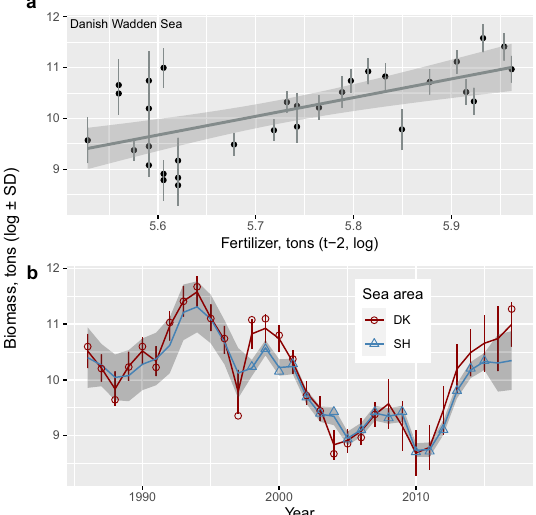
Figure 6. ( a ) Effect of fertilizer application to the Danish (DK) farmland on mussel biomass on the DK Wadden Sea two years later. ( b ) Estimated (lines) and observed (symbols) biomass trends of blue mussel populations in the DK and Schleswig–Holstein (SH) Wadden Sea in 1986–2017.